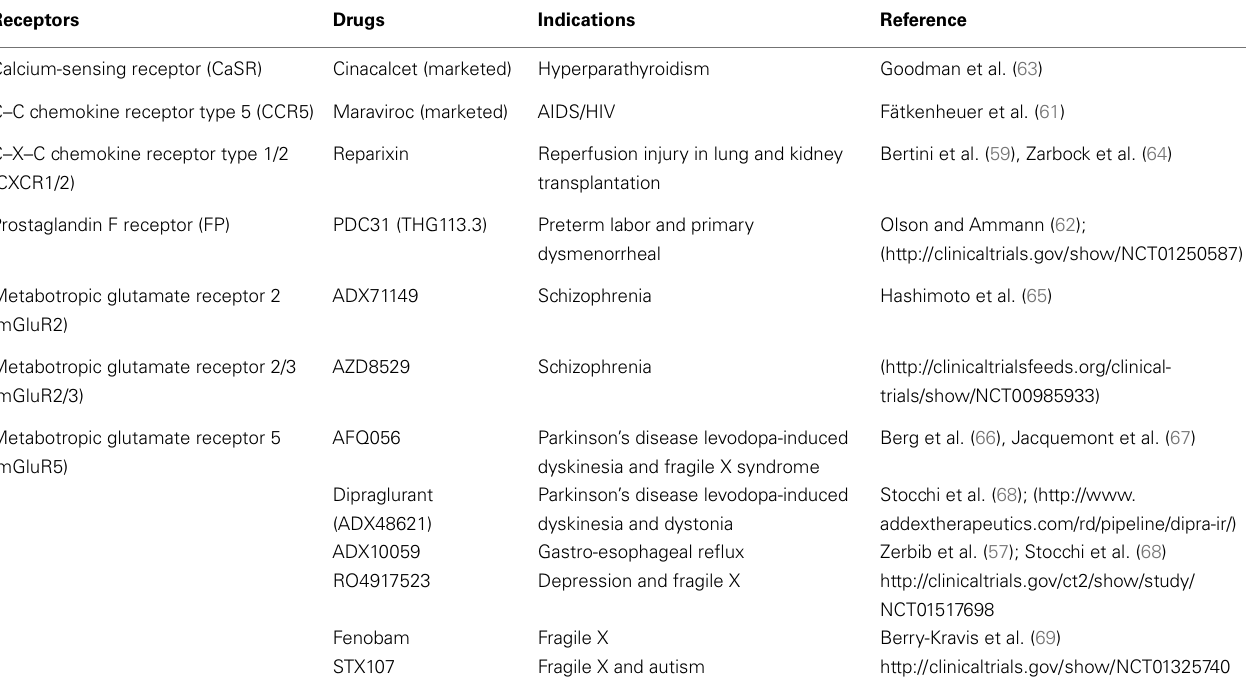
Table 2 | Potential therapeutic usage of allosteric and biased GPCR signaling compounds/drugs